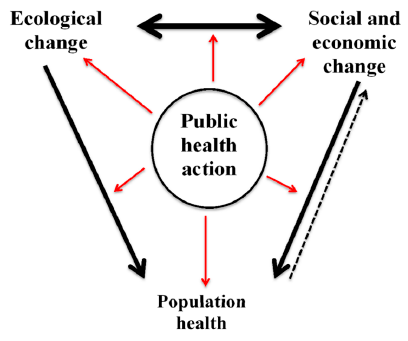
Figure 1. An Eco-Social Framework for Public Health Action (reproduced with permission from the CPHA) [10].